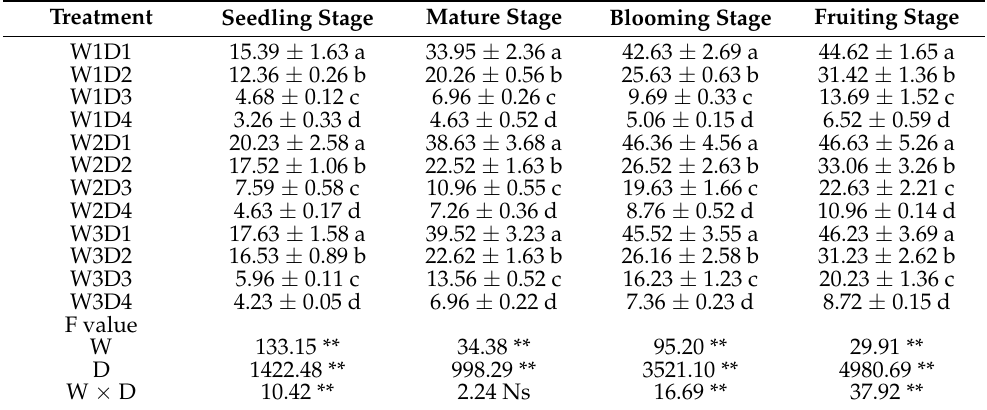
Table 3. Effect of different planting densities and irrigation volumes on the canopy width of Suaeda salsa under drip irrigation. Treatment Seedling Stage Mature